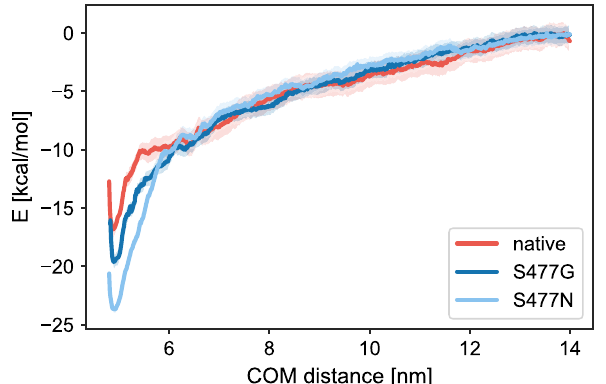
Figure 8. Potential of mean force calculation from SMD simulation of RBD and its S477 variants. The standard deviation is indicated by a semi-transparent band in the same colour.